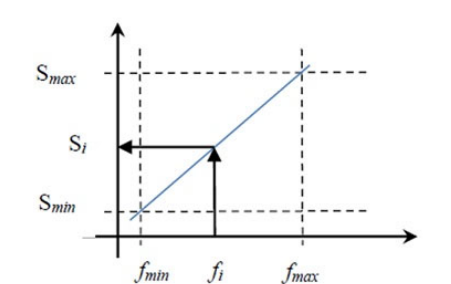
Fig. 6. Relationship Between Eligibility Value and Number of